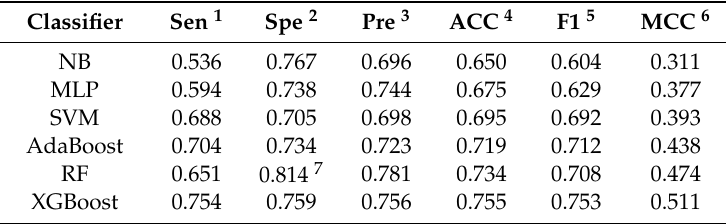
Table 2. Comparison of the di ff erent classifiers.